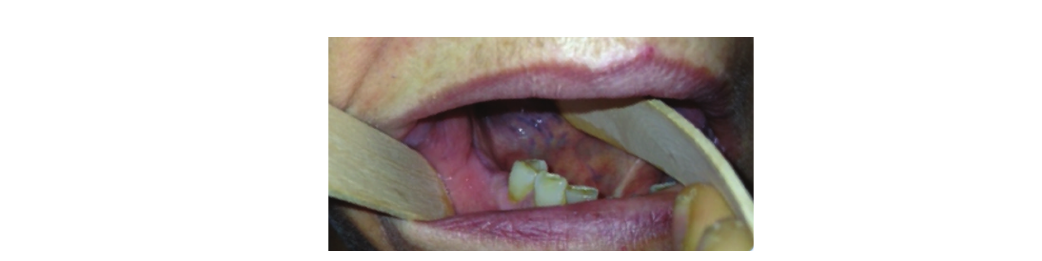
Figure 4: Schematic view of disease progression.